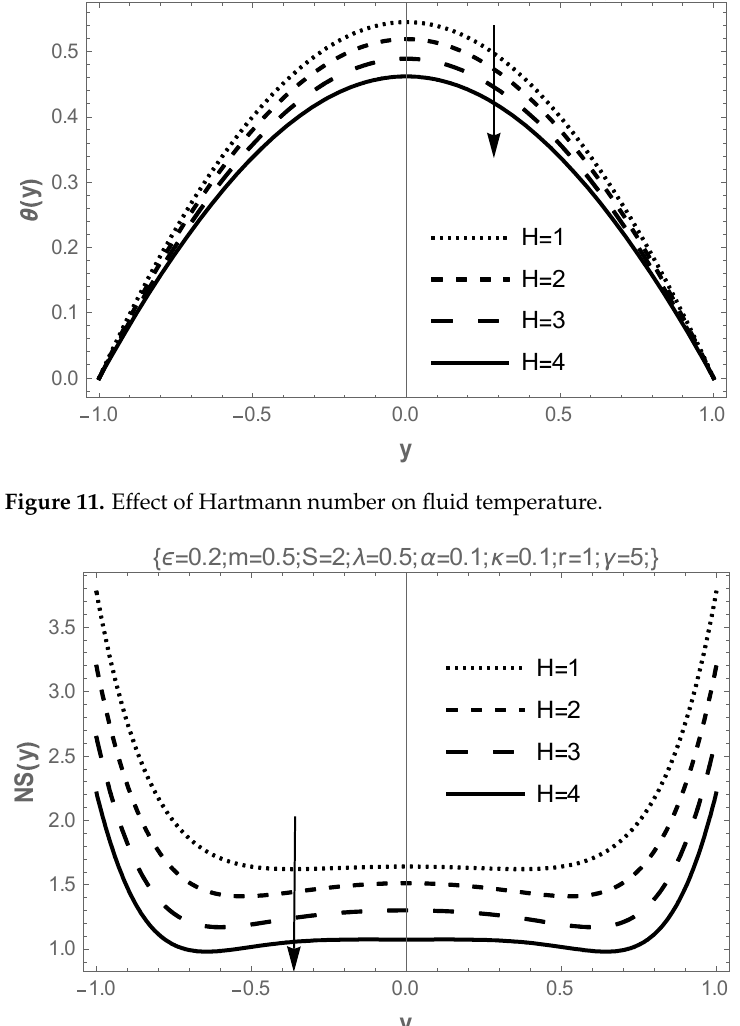
Figure 12. Effect of Hartmann number on entropy profile.